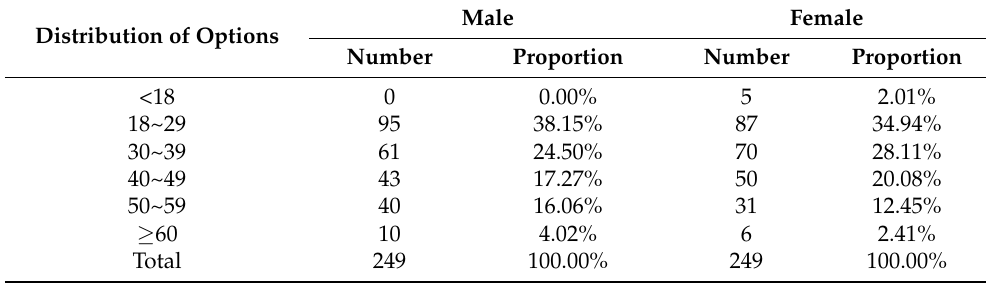
Table 6. Sex and age cross-comparison